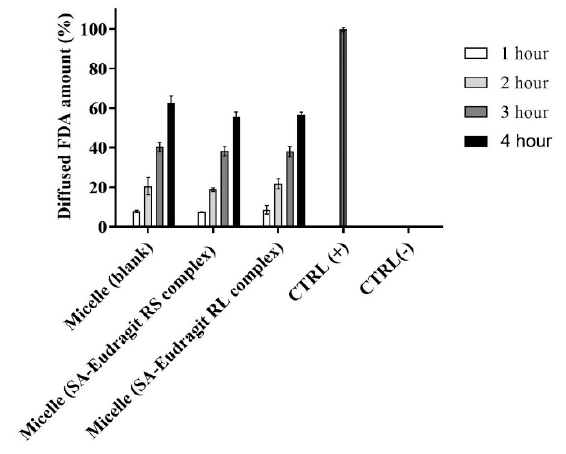
Figure 8. Diffusion behavior of micellar droplets loaded with 0.2% FDA through the intestinal porcine mucus as a blank or containing SA-polymer complexes after 1:100 dilution in 0.1 M phosphate buffer (pH 6.8) for 4 h at 37 °C. Indicated values are the means ± SD ( n ≥ 3).